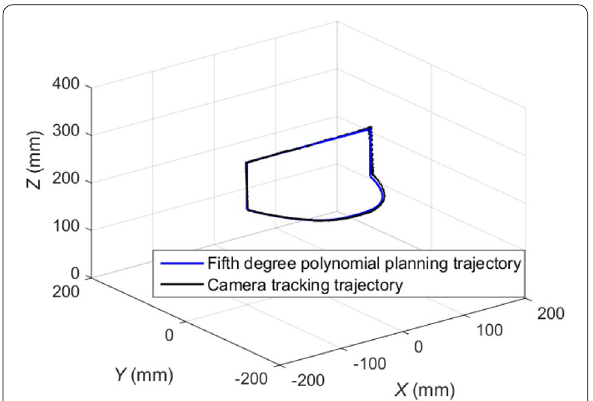
Figure 21 Camera tracking trajectory and fifth degree polynomial planning